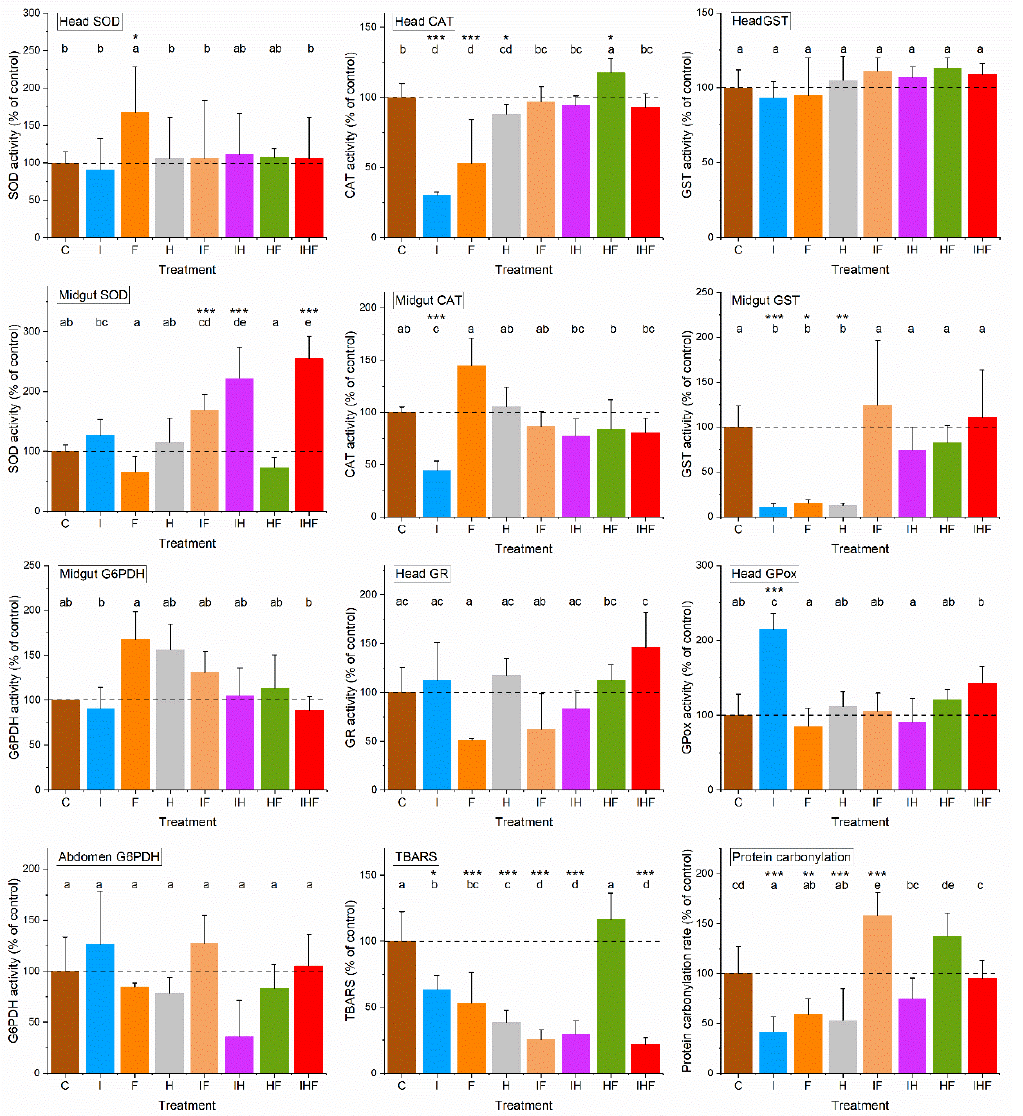
Figure 4. Effects of exposure to pesticides at 0.1 µ g/L on antioxidant defenses and oxidative